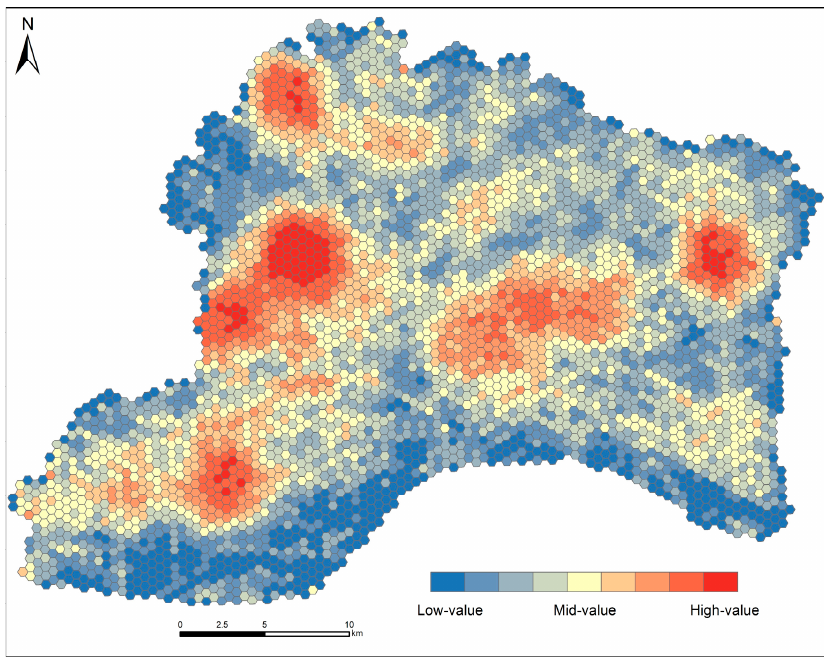
Figure 5. Spatial distribution of the cultivated land leisure service function in Yuanyang